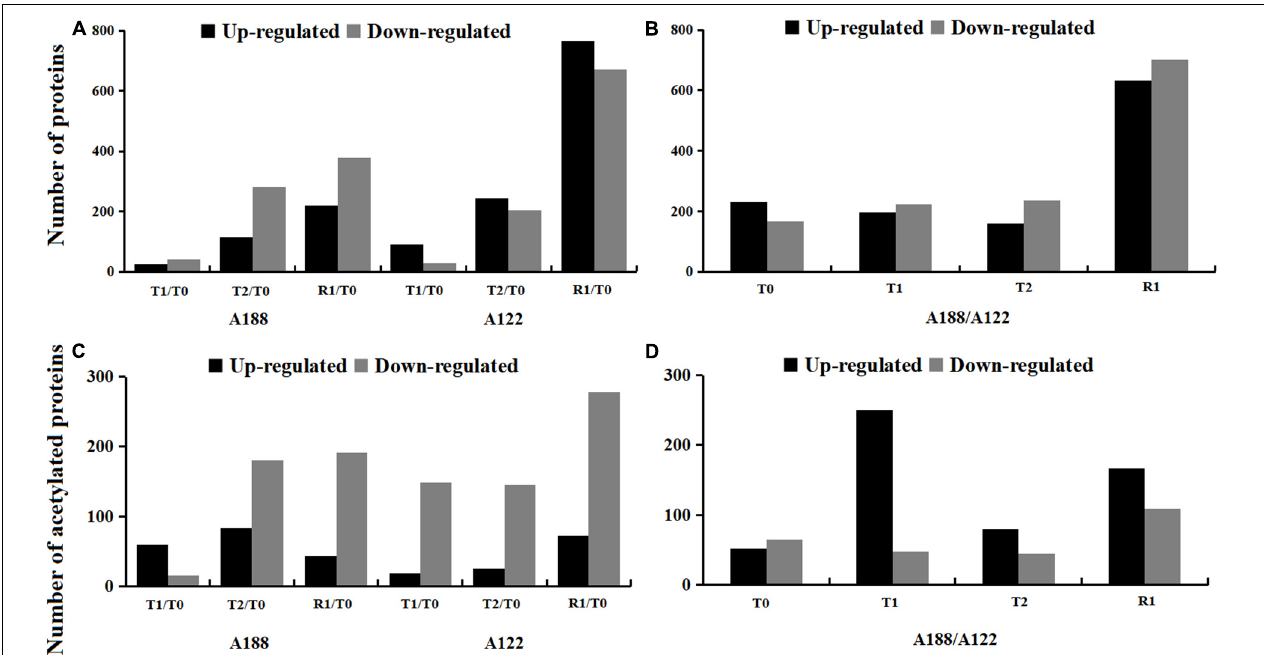
FIGURE 2 | Statistics of differentially expressed proteins/acetylated proteins under cold stress. (A) Numbers of differentially expressed proteins in different comparison groups. (B) Numbers of differentially expressed proteins between A188 and A122. (C) Numbers of differentially expressed acetylated proteins in different comparison groups. (D) Numbers of differentially expressed acetylated proteins between A188 and A122. The black and gray columns in the bar chart represent A188 and A122, respectively.